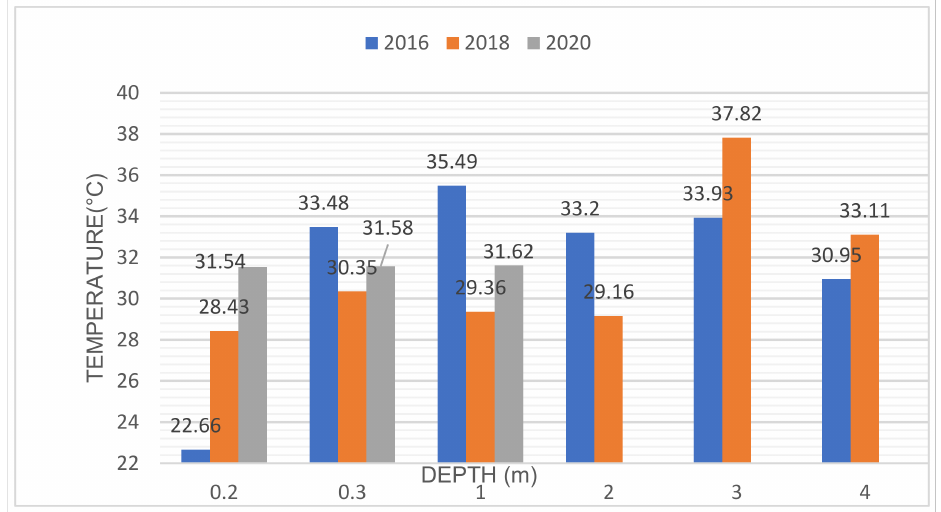
Figure 8. Temperature levels at several depths of Lake Ocnei.